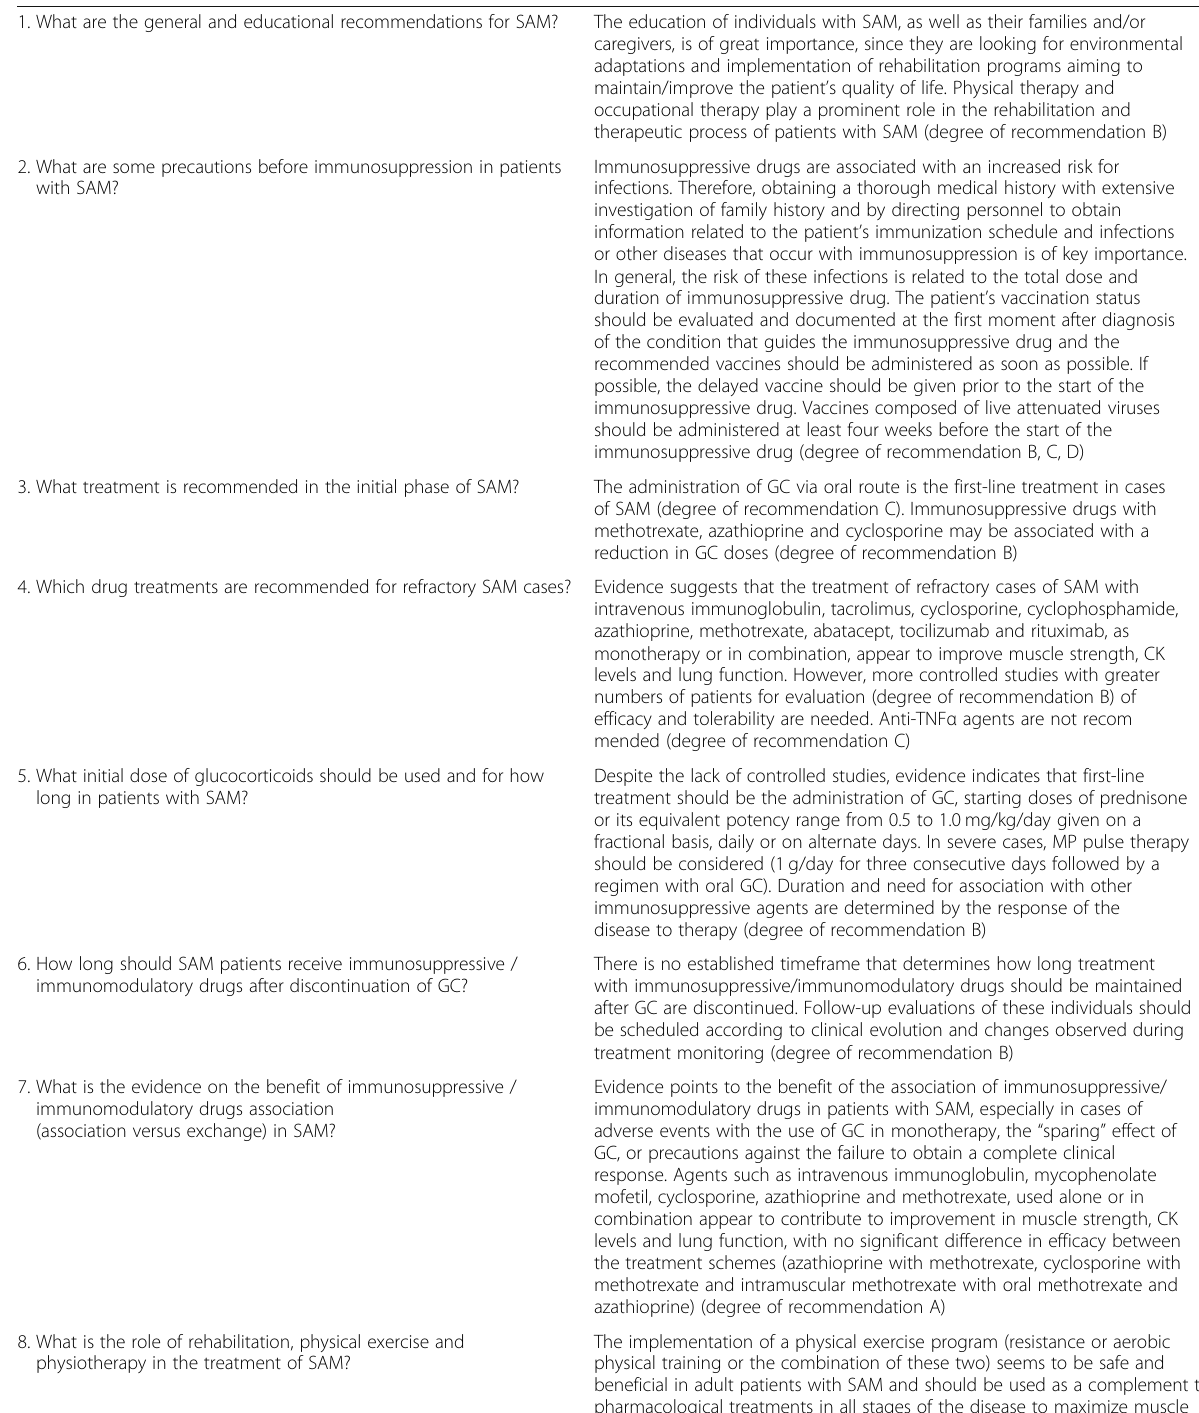
Table 3 Recommendations for the treatment of systemic autoimmune